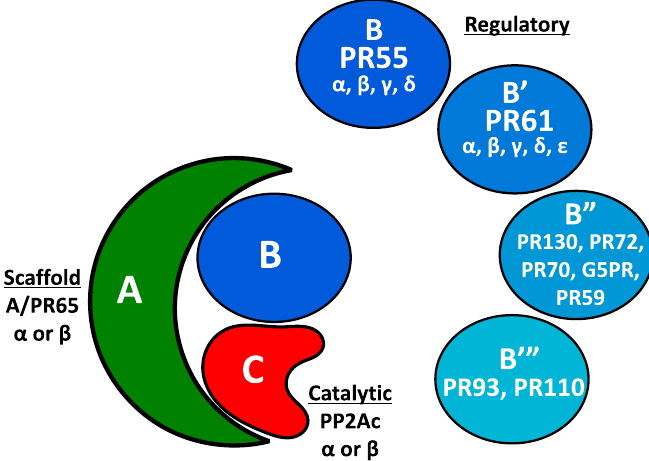
Figure 1. Serine-threonine protein phosphatase 2A (PP2A) holoenzyme. The PP2A holoenzyme consists of a scaffolding (A), regulatory (B), and catalytic (C) subunits. There are two unique scaffolding subunits (PP2A A α and PP2A A β ), and two unique catalytic subunits (PP2Ac α and PP2Ac β ). The regulatory (B) subunits consist of four diverse families: B or PR55, B’ or PR56/PR61, B”, and B’”. Within the B and B’ regulatory subunit families are multiple isoforms, denoted using Greek letters. A number scheme using approximate molecular weights (i.e., PR55 or PR56) is also commonly utilized for referencing PP2A subunits.